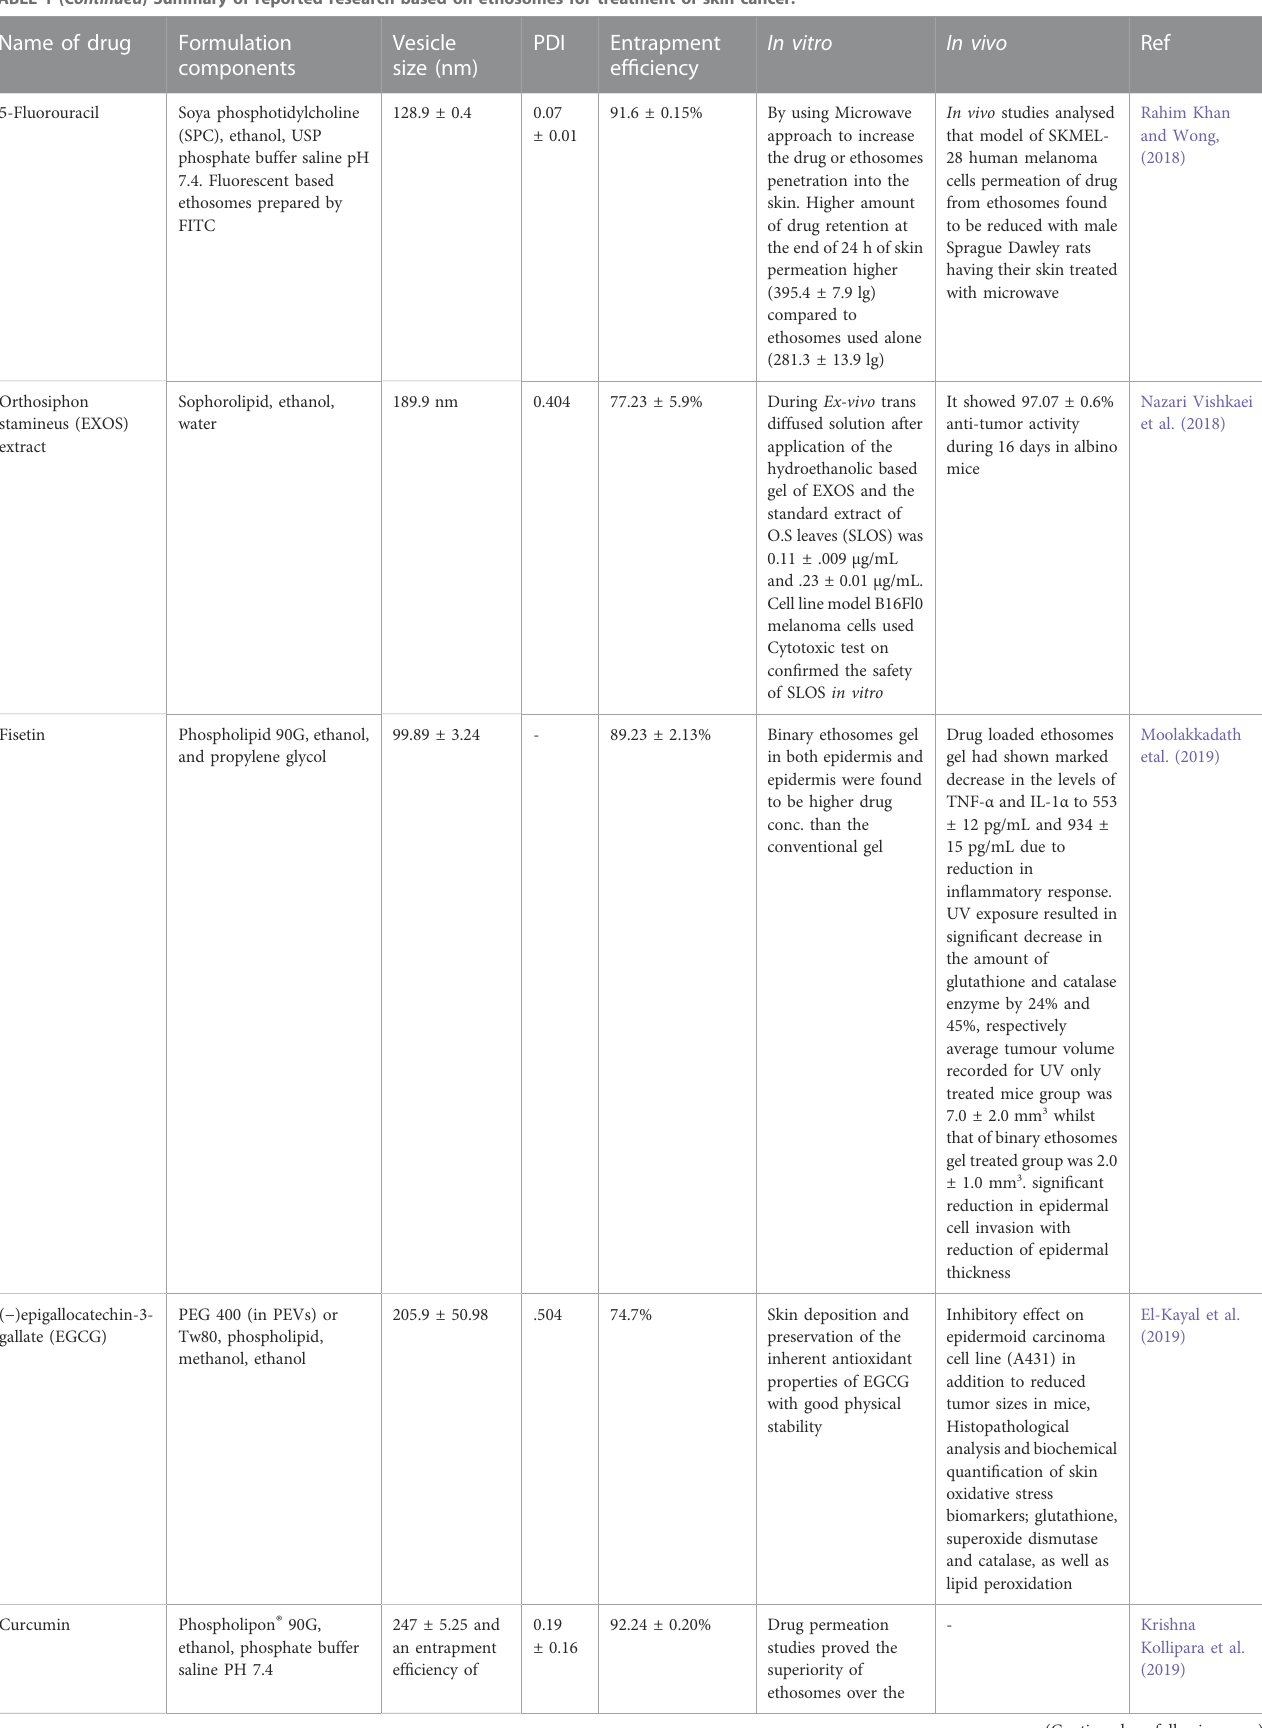
TABLE 1 ( Continued ) Summary of reported research based on ethosomes for treatment of skin